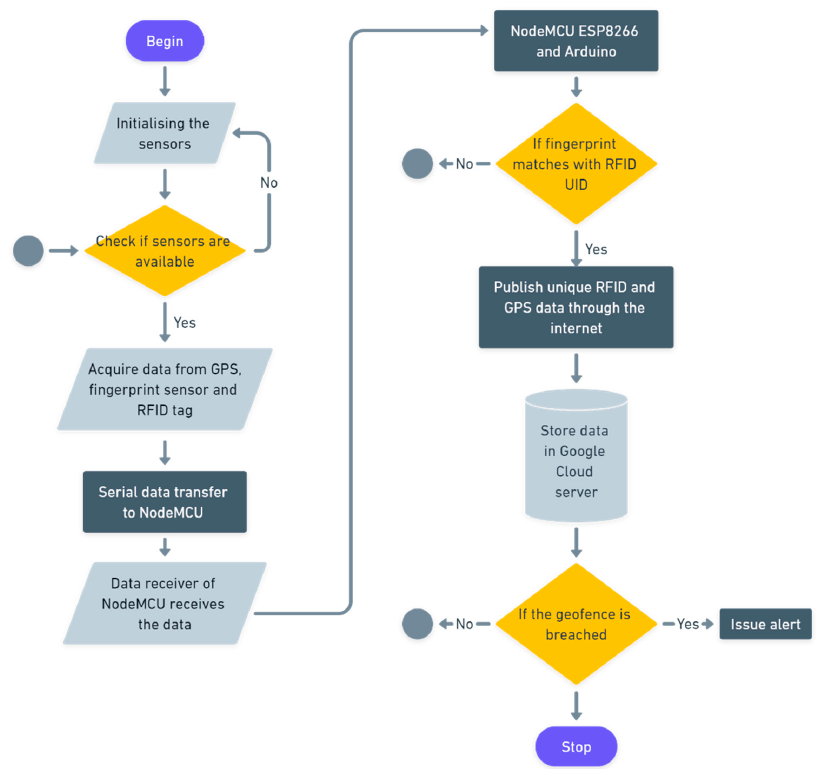
Figure 5. Flow chart of data collection, verification, and storage .